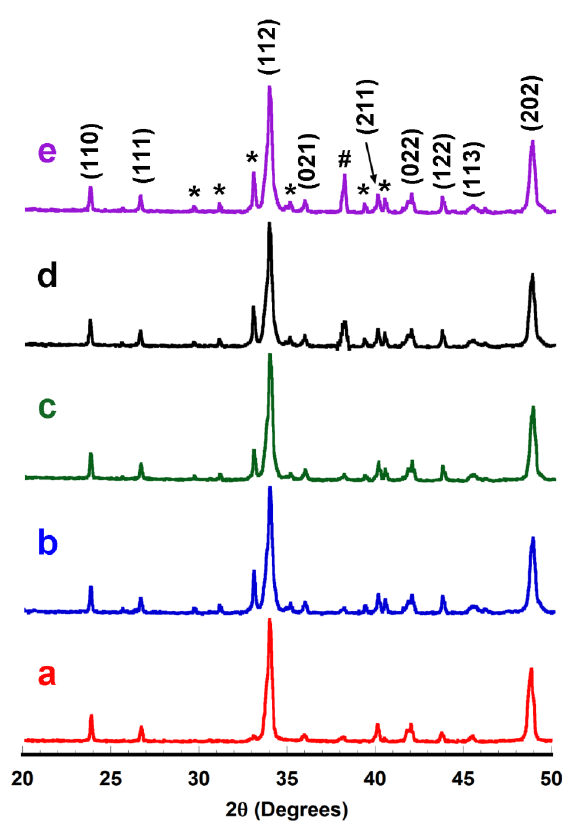
Figure 1. Powder X-ray diffraction (XRD) patterns, given in log scale on the y-axis, of Ca 0.9 Yb 0.1 MnO 3 + x wt.% Ag samples after sintering for x = ( a ) 0; ( b ) 1; ( c ) 3; ( d ) 5; and ( e ) 10. Diffraction planes identify the peaks of the Ca 0.9 Yb 0.1 MnO 3 phase, while * and # show those corresponding to Ca 2 Mn 2 O 5 and metallic Ag, respectively.